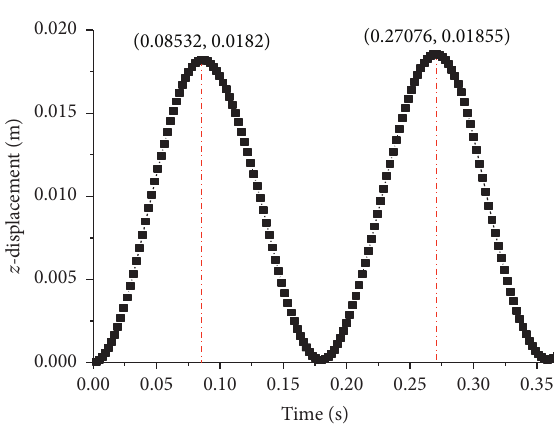
Figure 7: Dynamic load curve.